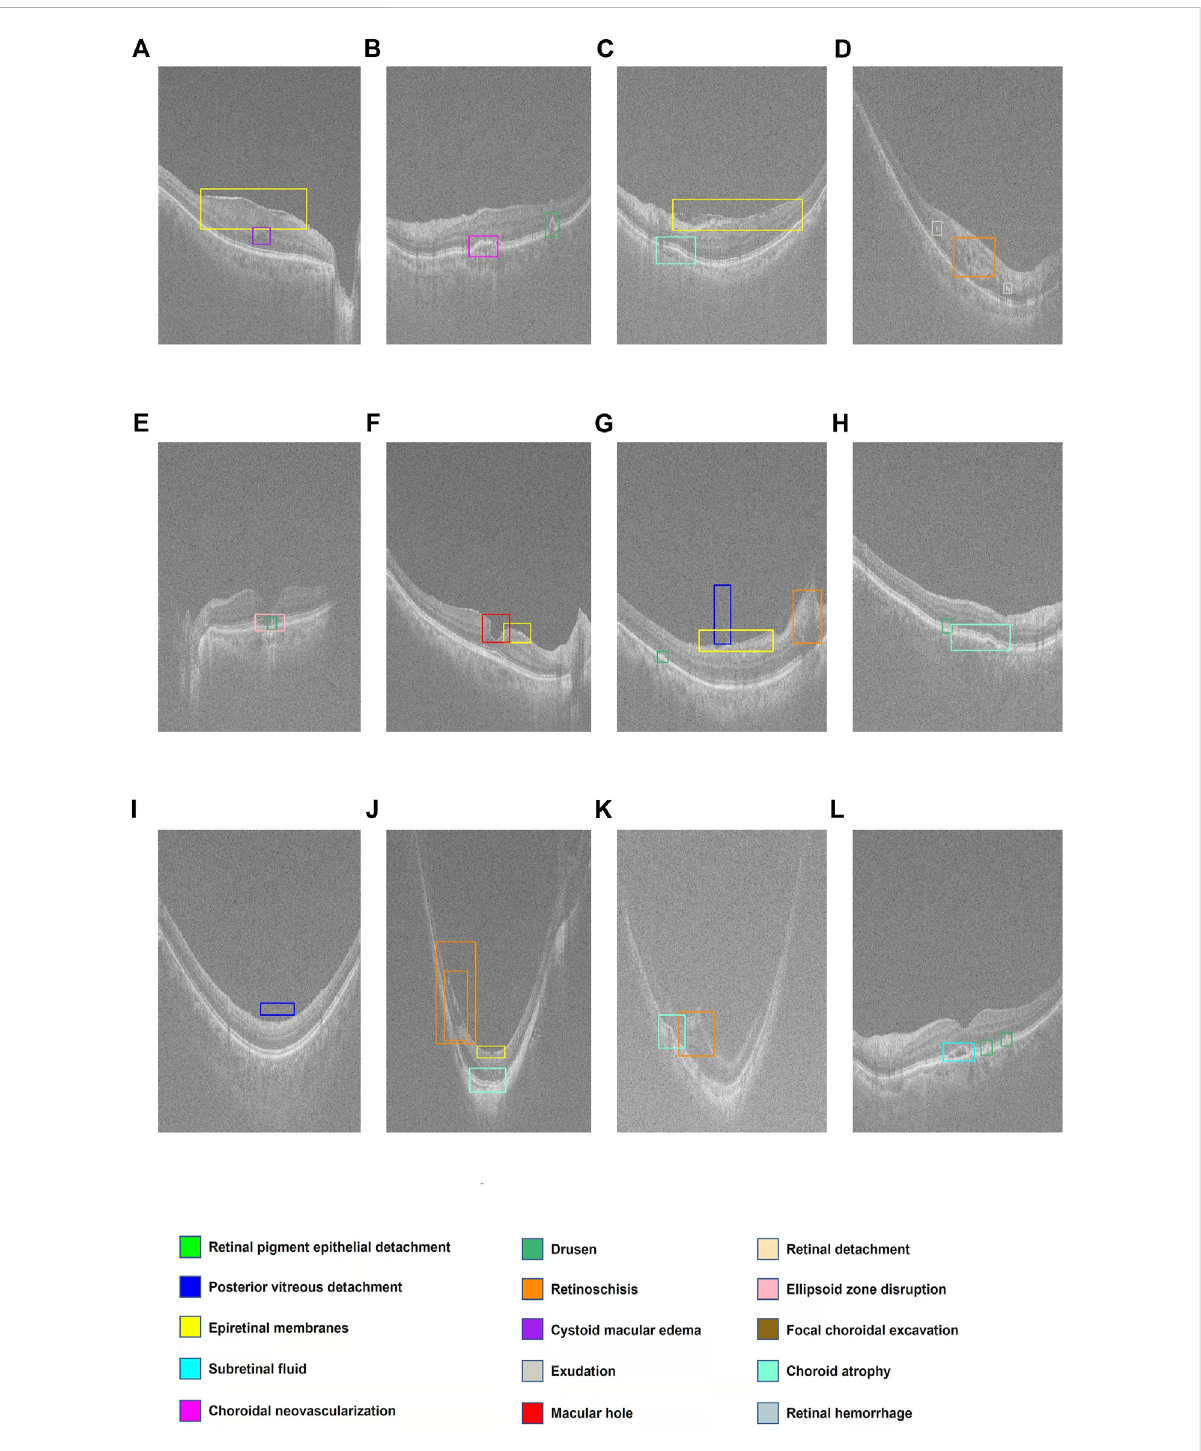
FIGURE 3 Display of multiple retinal disorders and their locations. (A – L) Fifteen categories of retinal disorders are marked by rectangles with speci fi c colors on OCT images.